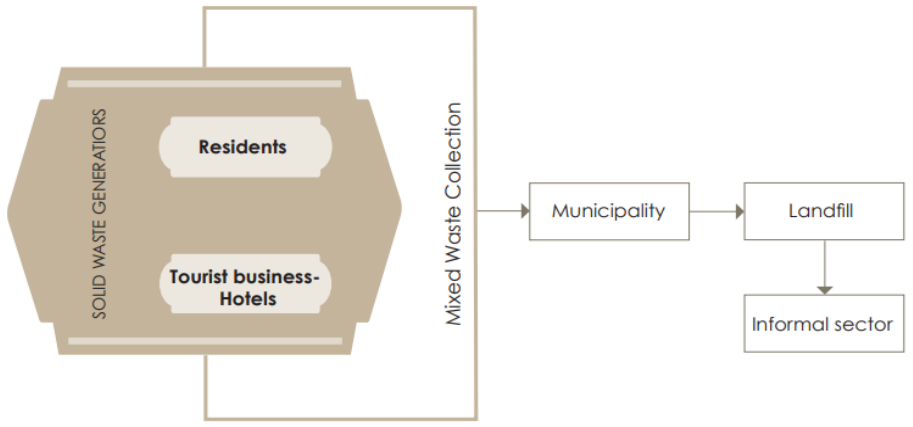
Figure 7. Case of mixed waste generation in hotels in Tunisia.